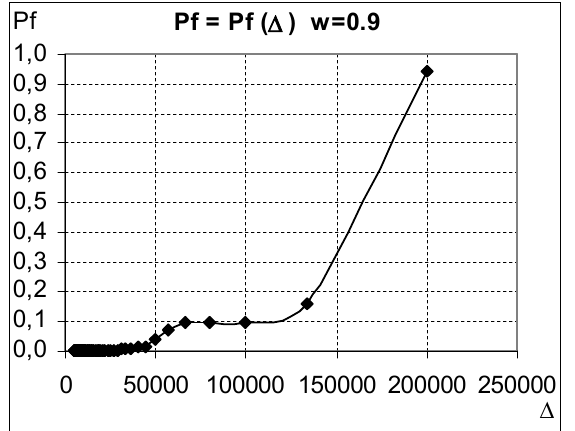
Fig 7. Failure probability in the case of m = 2 for the corroded specimens with specified life = 400000 cycles Pf = Pf ( D ) w=0.9